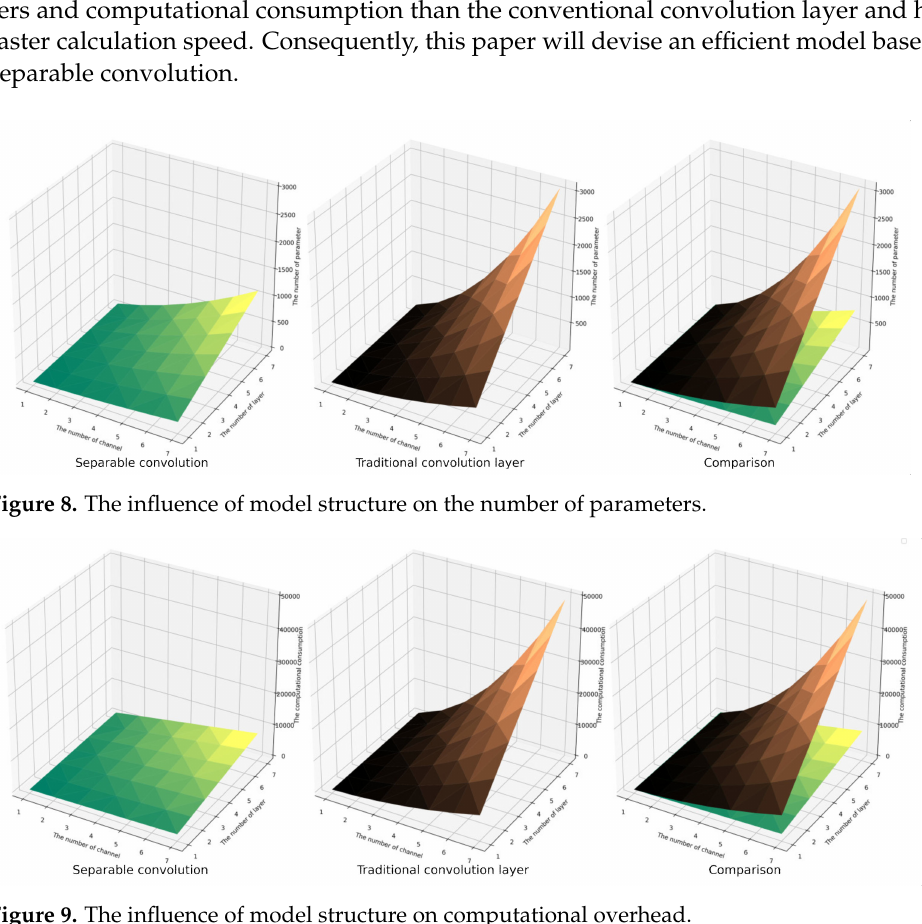
Figure 9. The influence of model structure on computational